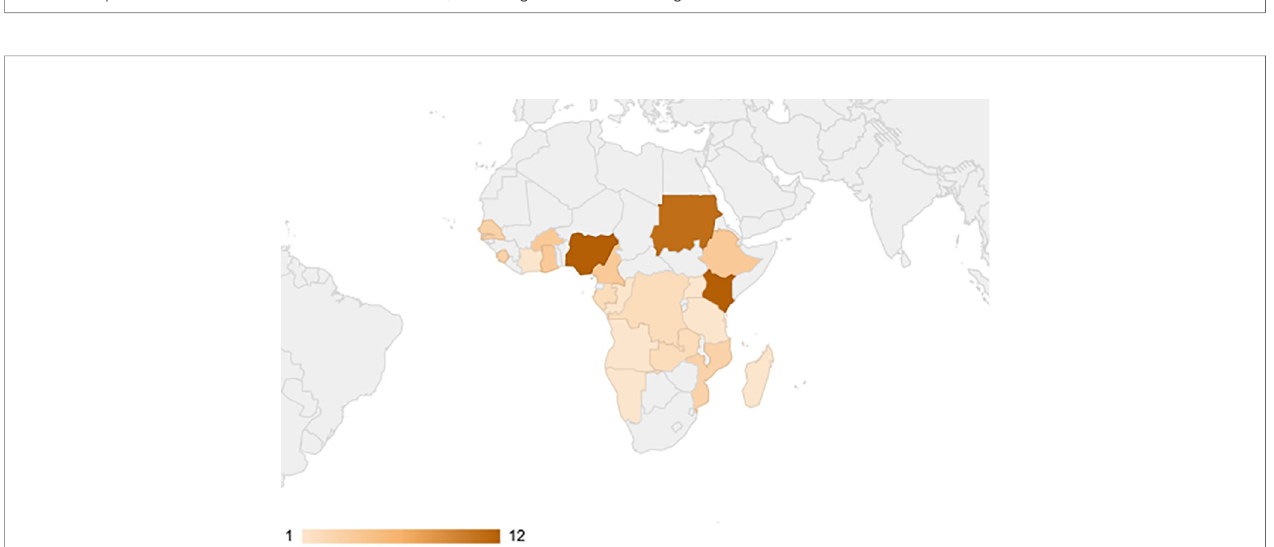
FIGURE 2 | ChoroplethmapofSub-SaharanAfricancountries weightedaccording tothenumber ofretrievedstudies. Noarticleswerefoundfrom countrieshighlightedingrey.